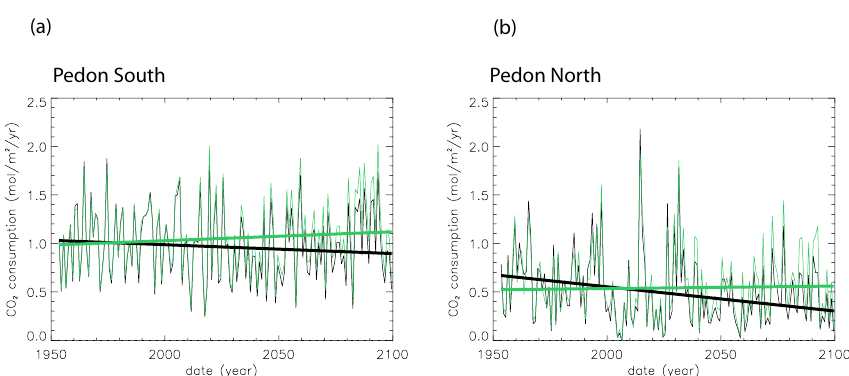
Fig. 3. Calculated yearly averaged CO 2 consumption by weathering reactions for the southern and northern sites. In black: reference runs. In green: simulations where the air temperature is held at the averaged 1950–1960 constant value. The straight lines are the mean square linear fits of the model outputs.